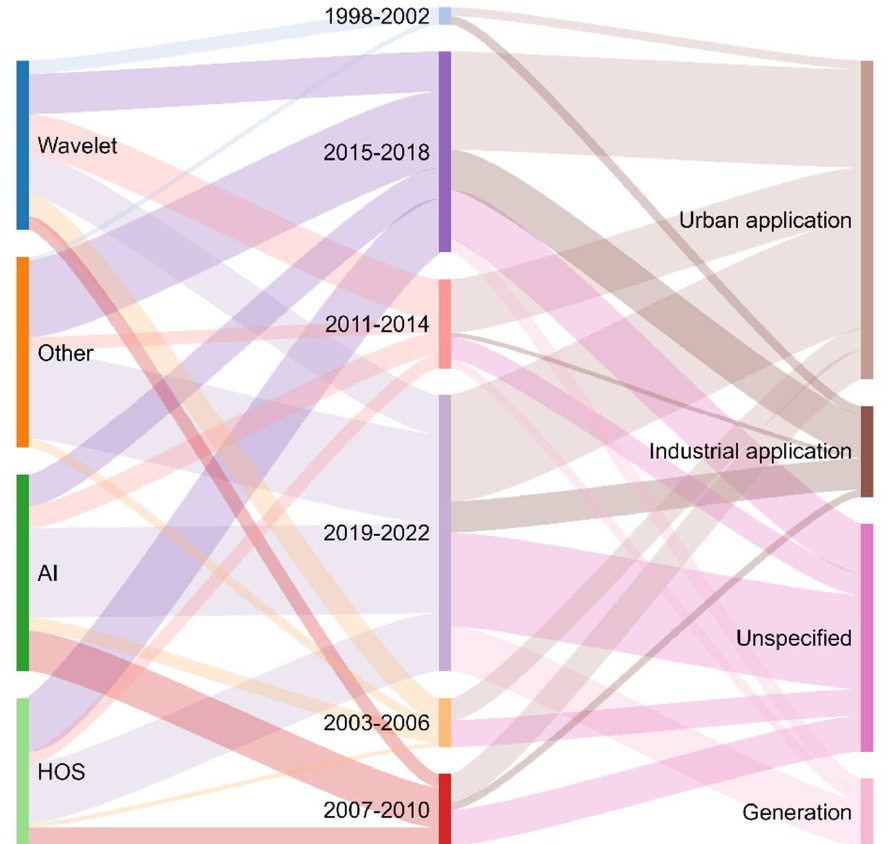
Figure 2. Parallel set that relates the method used with the year of publication of the paper and the environment in which it is focused.